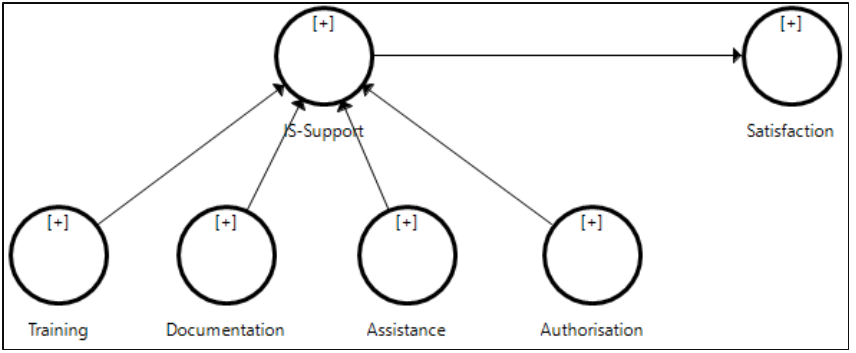
Fig. 1. The IS-Support Conceptual Model